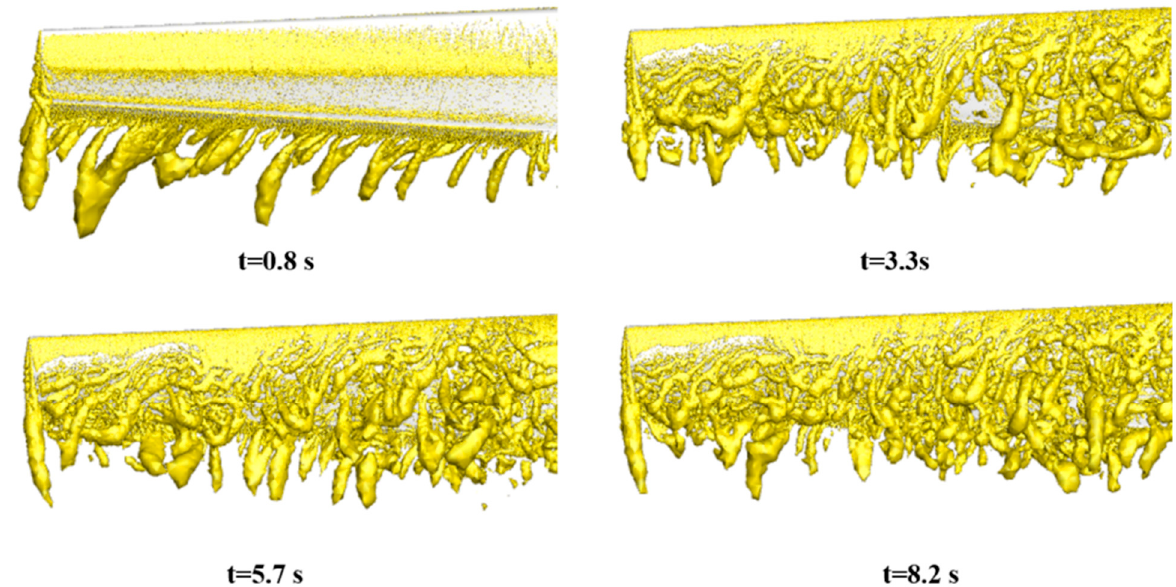
Figure 13. Vorticity magnitude levels for the serrated T6 blade at V = 10 m/s. Figure 13 . Vorticity magnitude levels for the serrated T6 blade at V = 10 m/s .